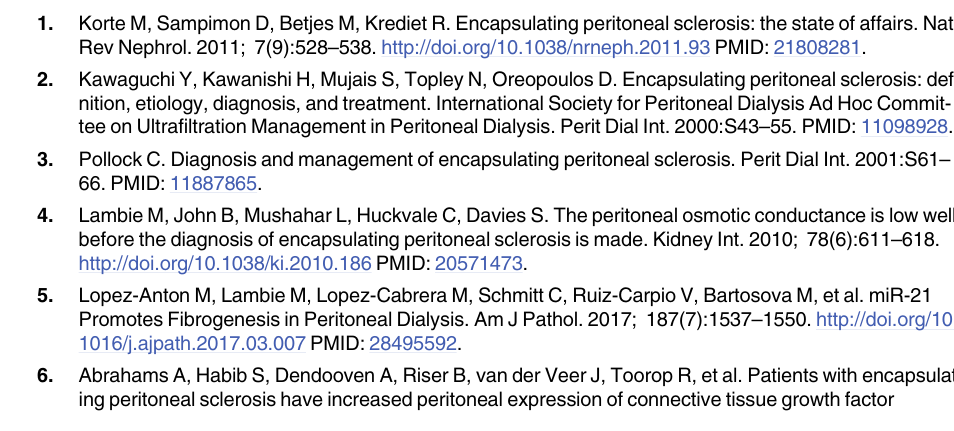
S3 Fig. Results of sensitivity analysis. (A) Age on dialysis. (B) D/P Cr. (C) PD duration. (D) peritonitis duration. (E) Use of icodextrin.